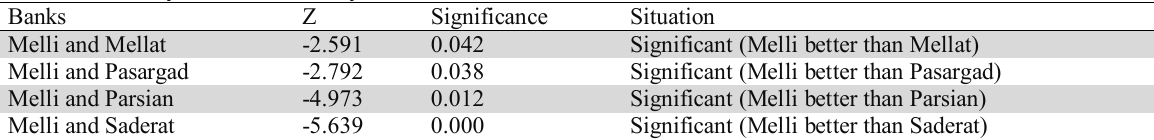
Mann-Whitney test for